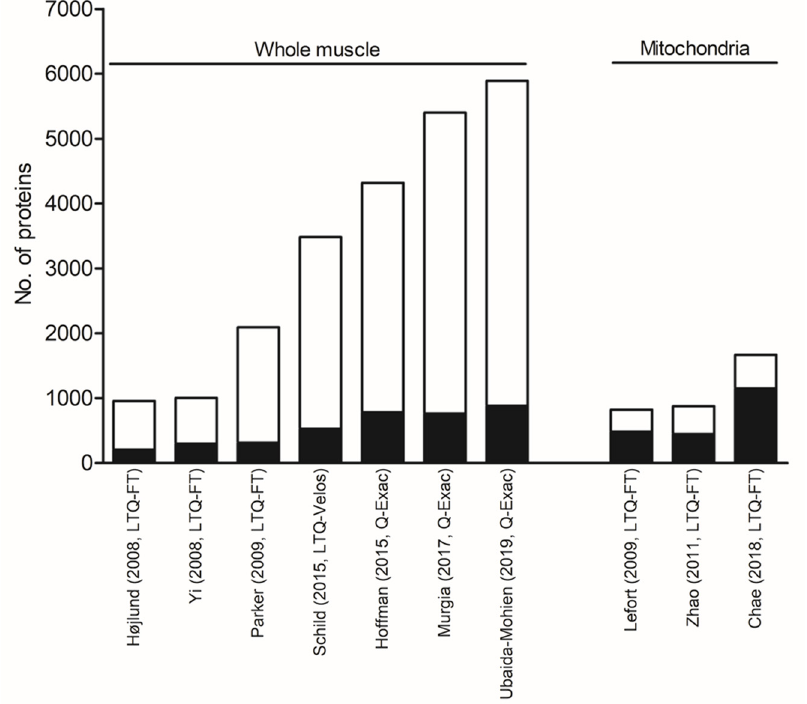
Figure 2. The number of proteins identified using discovery-mode proteomics on whole-muscle samples and isolated mitochondria from human skeletal muscle. The black part of the bars shows the number of non-mitochondrial proteins, while the white part represents the number of mitochondrial proteins identified in the respective studies identified by the first author, year of publication, and instrumental setup.